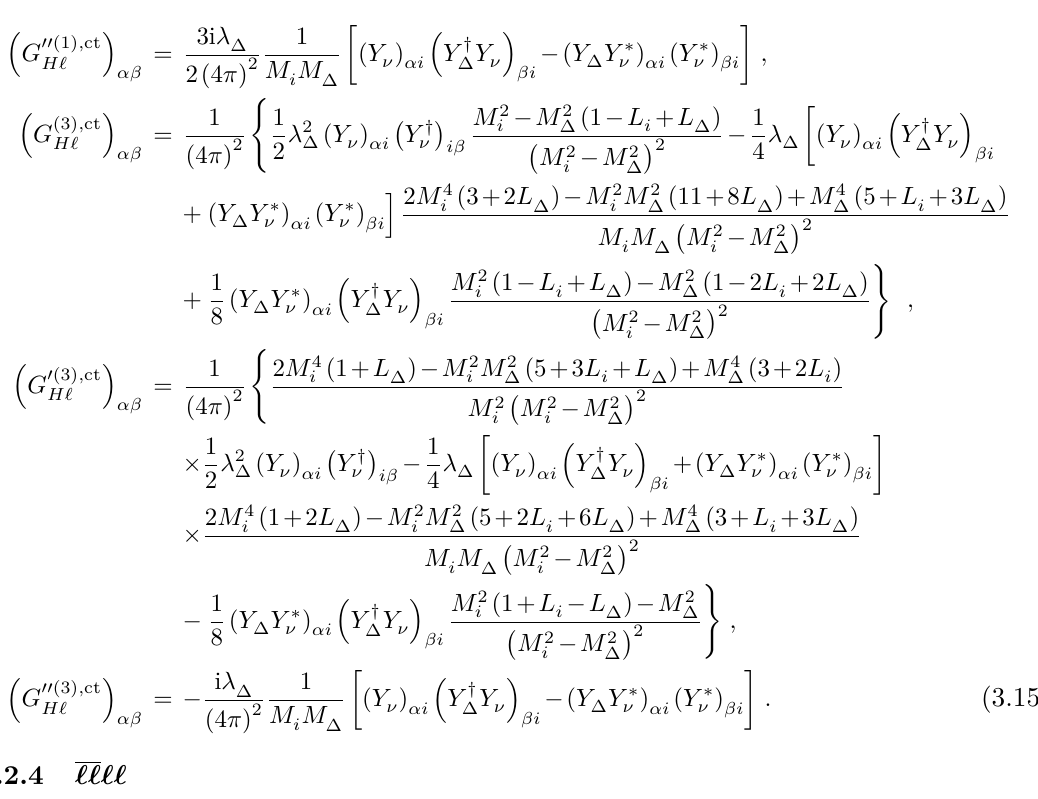
Figure 4 . The 1LPI diagrams with external lines generated by the (cid:0) ‘‘‘‘ (cid:1) field configuration in the type-(I+II) seesaw